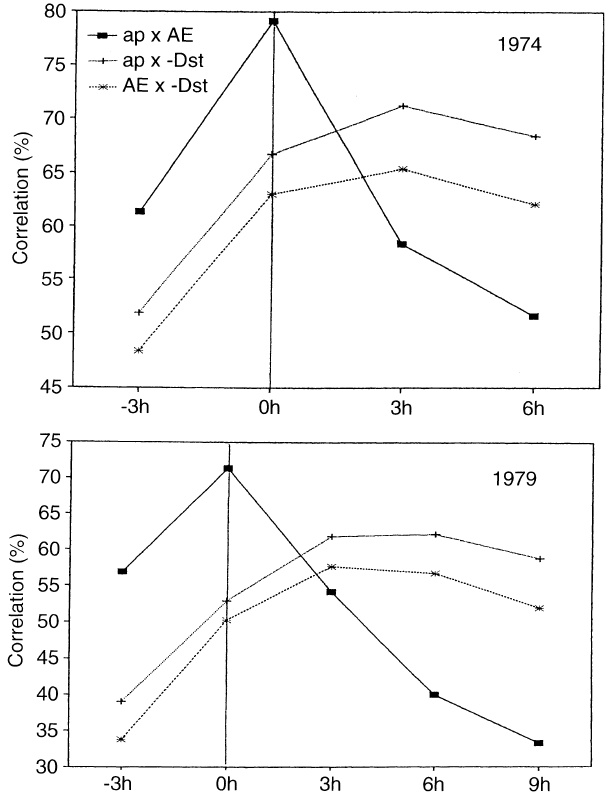
Fig. 3. Time-lag for annual correlations; the numbers in the x -axis represent the time-lag of the second index in relation to the